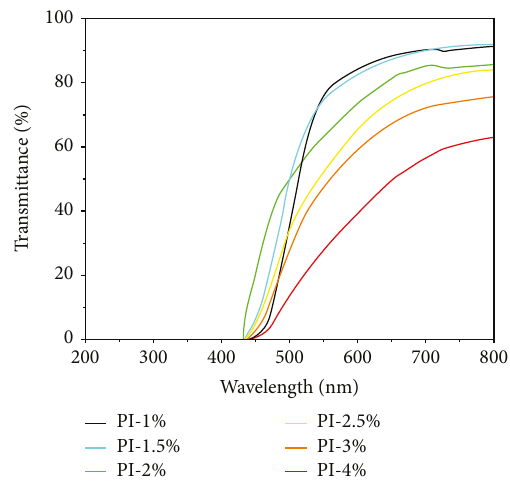
Figure 7: UV-vis spectral curves of PI composite fi